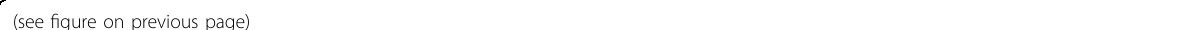
Fig. 1 Characterization of hAPP/hMAPT double-transgenic mice. A Western blot assays demonstrated AD-related protein levels in human wild- type APP and human wild-type Tau double-transgenic mice, a new AD mouse model. Wild-type mice, human wild-type APP transgenic mice, human wild-type Tau single transgenic mice, human wild-type APP, and Tau double-transgenic mouse hippocampus were collected at 12 months of age. APP NT (for both mouse and human APP), Tau5 (for both mouse and human Tau), HT7 (for human Tau) antibodies were applied to validate the double-transgenic model. Arrow indicated full-length AEP (~56 kDa), arrowhead indicated activated (mature) AEP (~37 kDa). Quantitative analysis of relative mRNA levels can be found Supplementary Figure 1. B Immuno fl uorescent staining showed AD-like pathologies in the WT, two single transgenic lines, and human APP/MAPT mice, including amyloid deposition (A β antibody), Tau hyperphosphorylation (AT8 antibody), neuroin fl ammation (Iba1 antibody) and the dendritic reduction in the remained neurons (MAP2) as well as cleaved-Caspase3 (Casp3). The speci fi c antibodies of AEP-cleaved APP (C586) and Tau (N368) were used for the detection of AEP activation (left, sale bar: 50 μ m). Quantitative analysis the percentage of positive cells. The number of Iba1 + microglia cell body was count and then calculated as mean±SEM × 10 3 /mm 3 . (right, Mean±SEM, n = 6 mice for each group, one-way ANOVA with Dunnett ’ s multiple-comparisons test. * as compared to WT mice, # as comparison to hAPP/hMAPT mice). C The formation of amyloid plaques and neuro fi brillary tangle (NFT) in four lines of mice at one-year old were shown by co-staining of ThS + A β and ThS + AT8, respectively (left. Scale bar: 50 μ m). Quantitative analysis to demonstrate the size of A β + plaque and AT8 + NFT (right. Mean ±SEM, n = 6 mice in each group, one-way ANOVA with Dunnett ’ s multiple-comparisons test, * as compared to WT mice, # as comparison to hAPP/ hMAPT mice). D Morris water maze analysis as the percentage of time spent in the target quadrant in the probe trial (left) and the latency time (right, AUC: area under the curve) to the platform in the training days. (Mean ± SEM, n = 12 mice for each group, one-way ANOVA with Dunnett ’ s multiple- comparisons test, * as compared to WT, # as comparison to hAPP/hMAPT mice). E Fear conditioning tests. Contextual (left) and cued (right) fear conditioning were time-dependently impaired in mice after the virus. (Mean± SEM, n = 12 mice for each group, one-way ANOVA with Dunnett ’ s multiple-comparisons test, * as compared to WT mice, # as comparison to hAPP/hMAPT